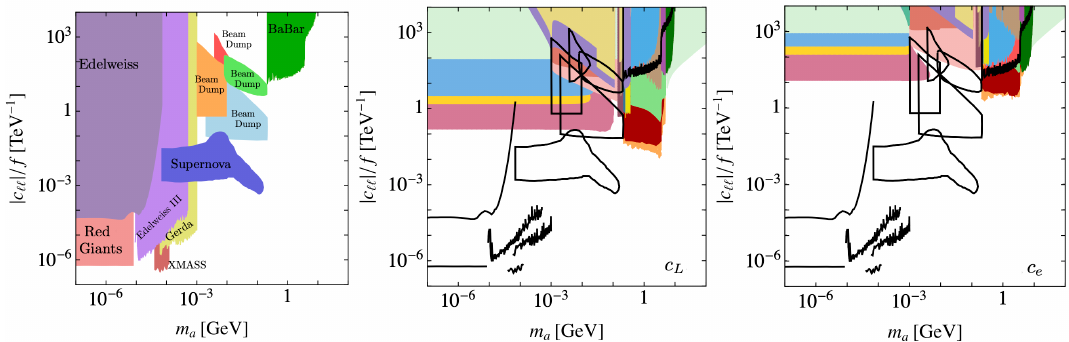
Figure 28 . Left: astrophysical, beam dump, and collider constraints on ALP couplings to leptons c ‘‘ = c e − c L (see text for further details). Center and right: in color, we show flavor constraints on ALPs coupling to either SU(2) lepton doublets (central, as in figure 26 above) and lepton singlets L (right, as in figure 27), respectively. For easy comparison, the black contours depict the bounds from the left